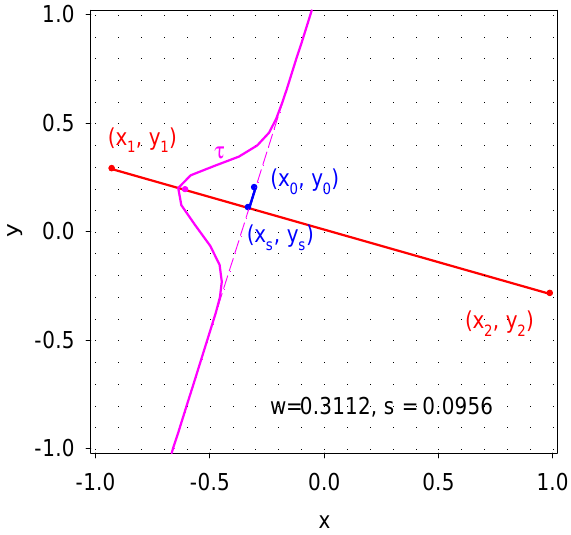
Fig. A7. Example of a contrail-segement between end-points (x 1 ,y 1 ) and (x 2 ,y 2 ) (red) with closest connection (blue) from a point (x 0 ,y 0 ) in the cloud mask to (x s ,y s ) on the contrail center- line, and contribution to optical depth τ (see Sects. 2.15 and